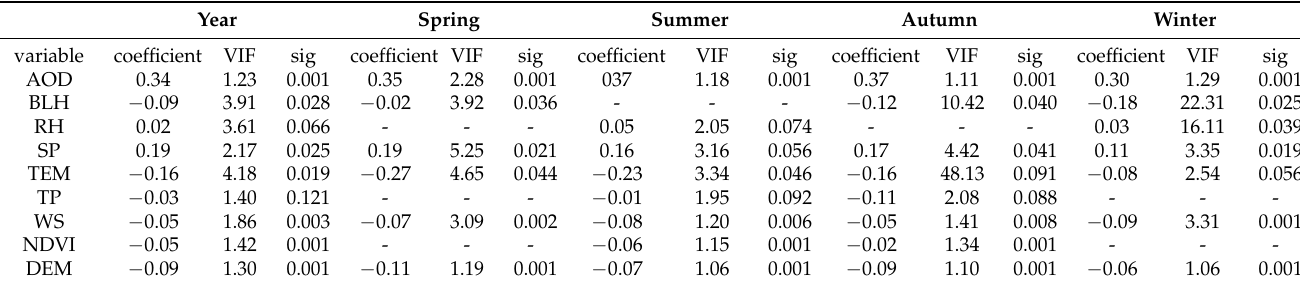
Table 1. Variable selection